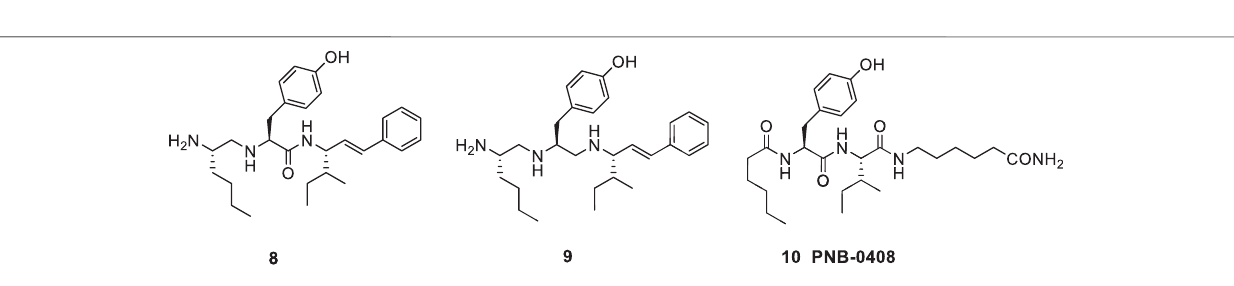
Figure3| Thelowmolecularweighthigh-af fi nityangiotensinIV(AT4)receptorbindinganalogues 8 and 9 incorporateoneortworeducedpeptidebonds.PNB-0408 ( 10 ),devoidofanN-terminalaminogroupcrossestheblood-brainbarrier,enhancescognitionand isinterferingwiththehepatocytegrowthfactor/c-Metreceptorsystem.